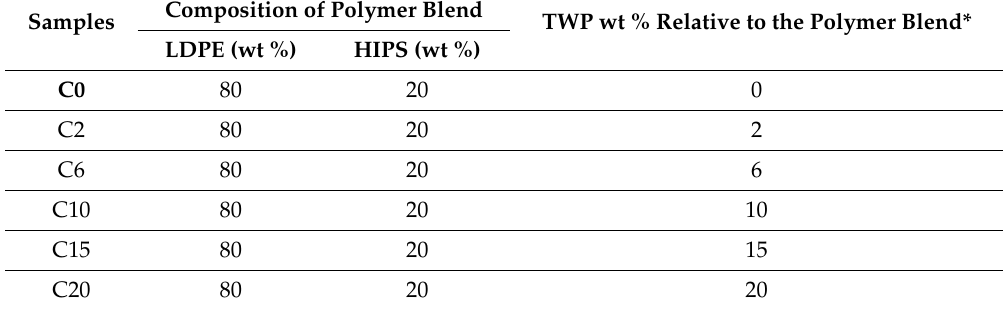
Table 1. Compositions of the composites low-density polyethylene / high impact polystyrene / toner waste powder (LDPE / HIPS /